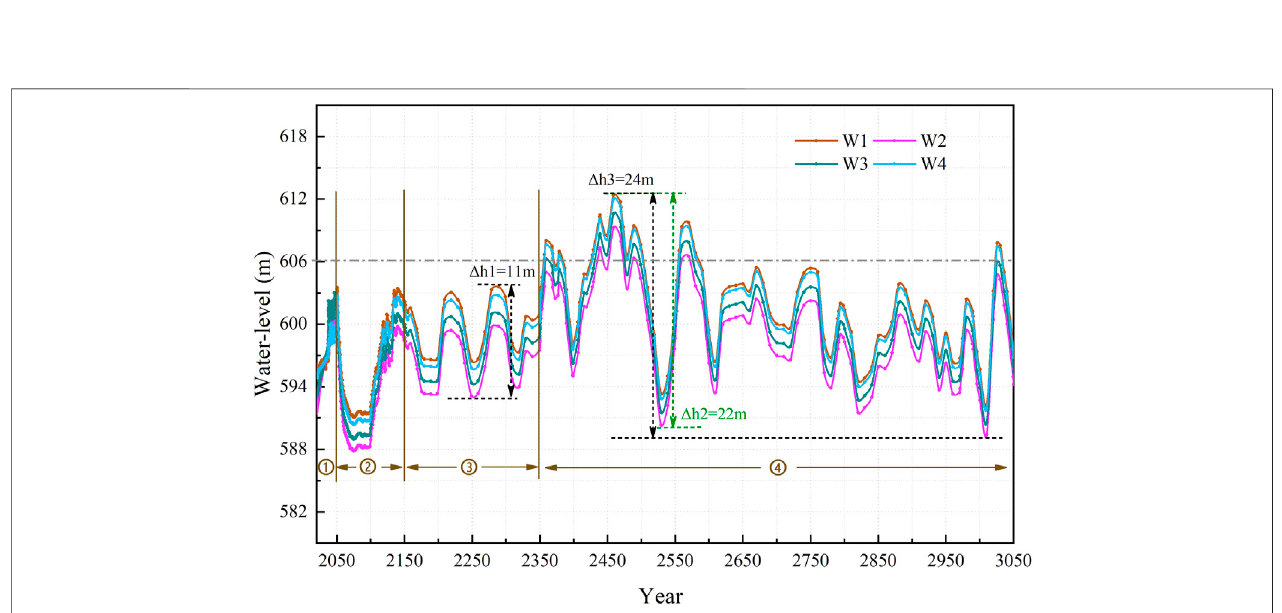
FIGURE 7 | Variation curves of groundwater levels of LILW repository from 2,020 to 3,050.